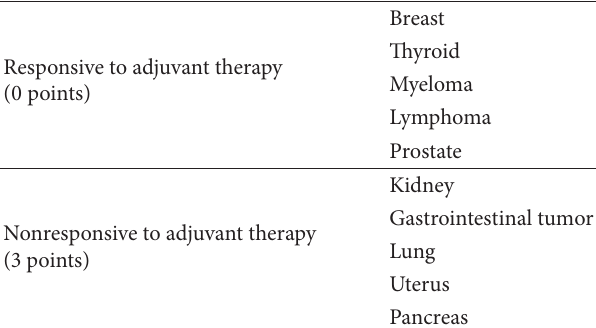
Table 5: Predictive response to adjuvant treatment and scoring for the